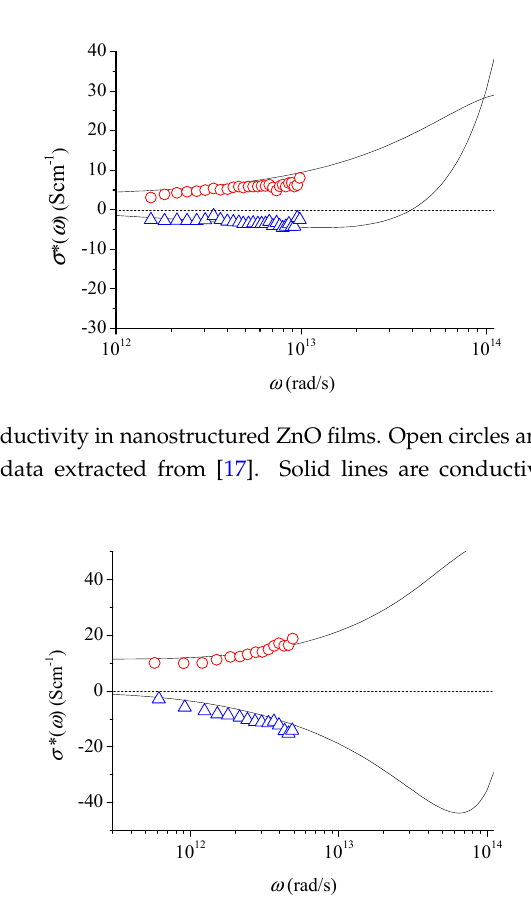
Figure 8. Complex conductivity in single crystalline epitaxial ZnO films. Open circles and triangles are the experimental data extracted from [31]. Solid lines are the conductivity predicted from the SSFTC model. A good fit of the Drude law to the experimental results in epitaxial GaN has been also reported [32]. As already stated, the Drude-Smith model [21], in principle, should be applied to single crystalline materials since the disorder effect is not important in the DS model; it is simply a generalization of the Drude formula. No such non-Drude behavior, which fits to the DS model, is reported. It was stated that the SSFTC mechanism produces the Lorentz-type resonance, as shown in Figure 3. In the Lorentz resonance, however, conductivity at a low frequency should be zero. Therefore, the SSFTC model produces a similar trend to the Lorentz resonance. As shown in Figure 9, when we change physical parameters, e.g., a decrease of f in Equation (4), in which the tunneling contribution becomes large, the resonant conductivity predicted by the SSFTC model (solid lines) becomes very close to that using the Lorentz resonance (dashed lines), described as [1,3]: